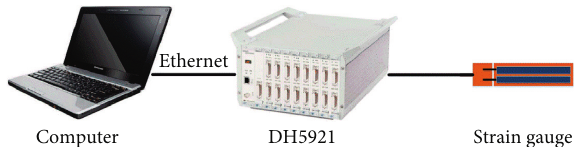
Figure 31: DH5921 dynamic strain testing system.